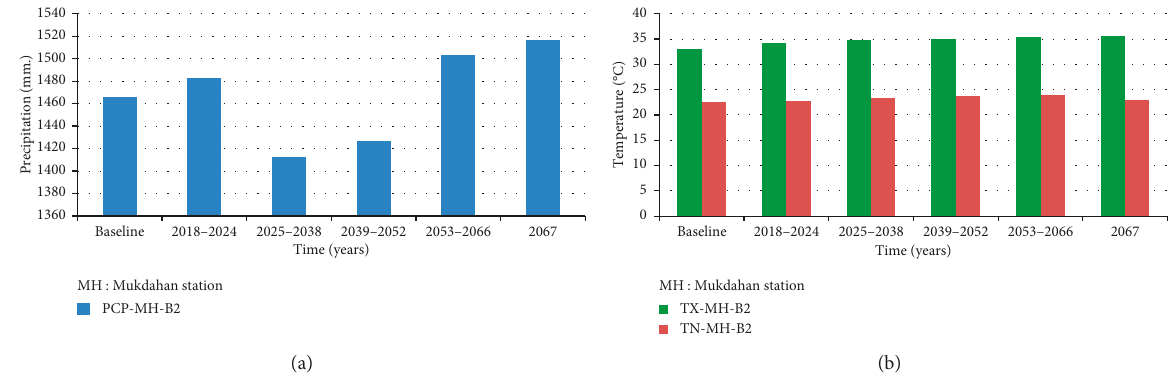
Figure 16: Future climate trends compared to baseline. Table 11: Accepted effective indexes of sensitivity parameters for four stations.